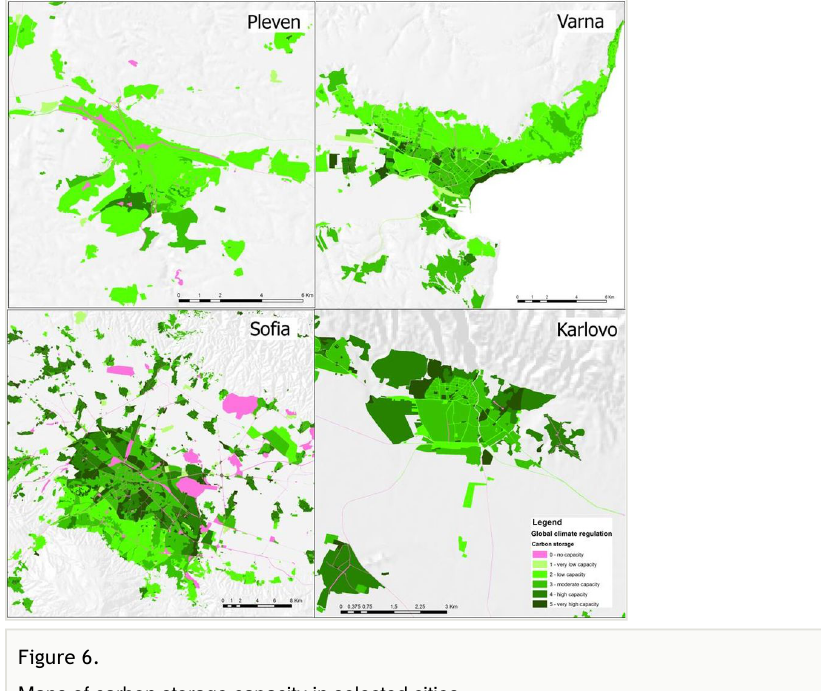
Figure 6. Maps of carbon storage capacity in selected